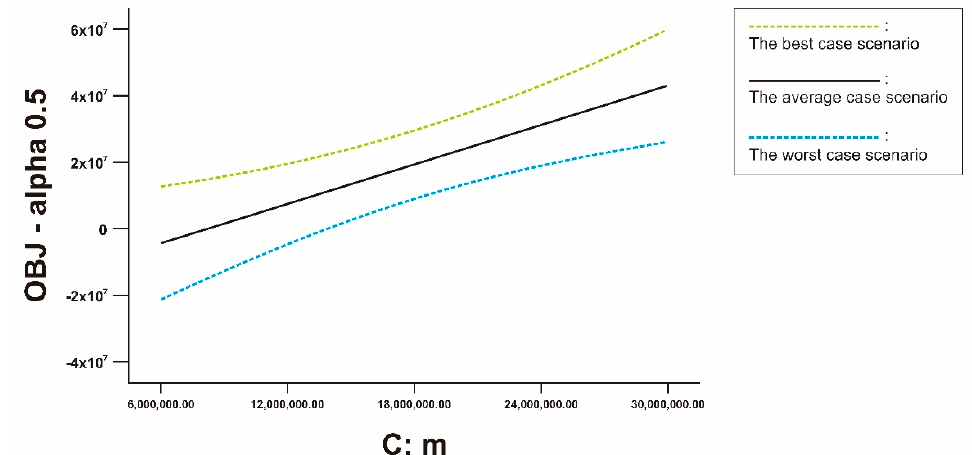
Figure 5. Objective function diagram as a function of parameter µ and wi with lower demand limit and α = 0.1.